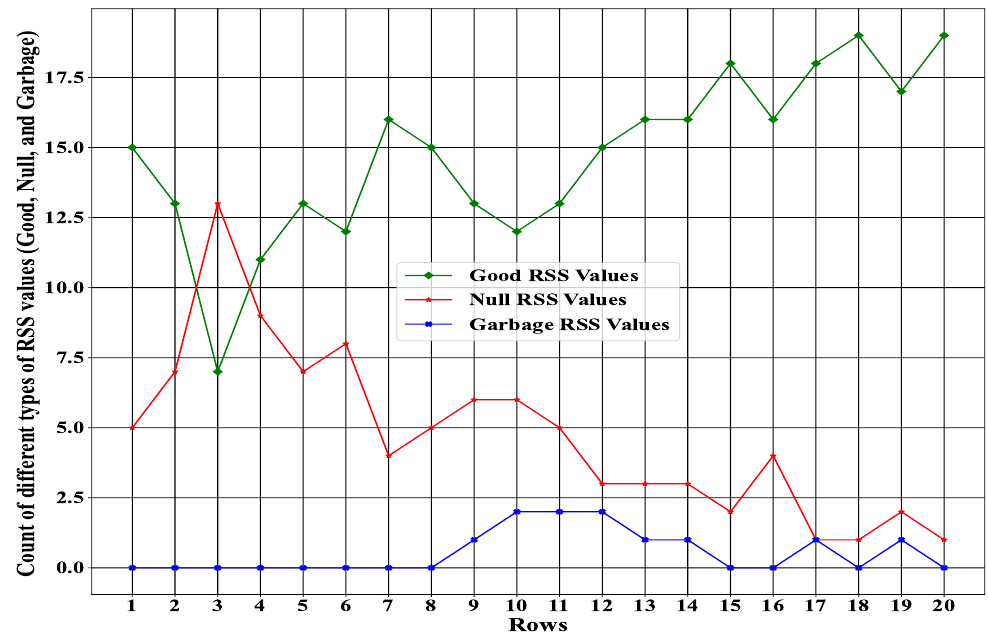
Figure 7. Total numbers of different RSS values.